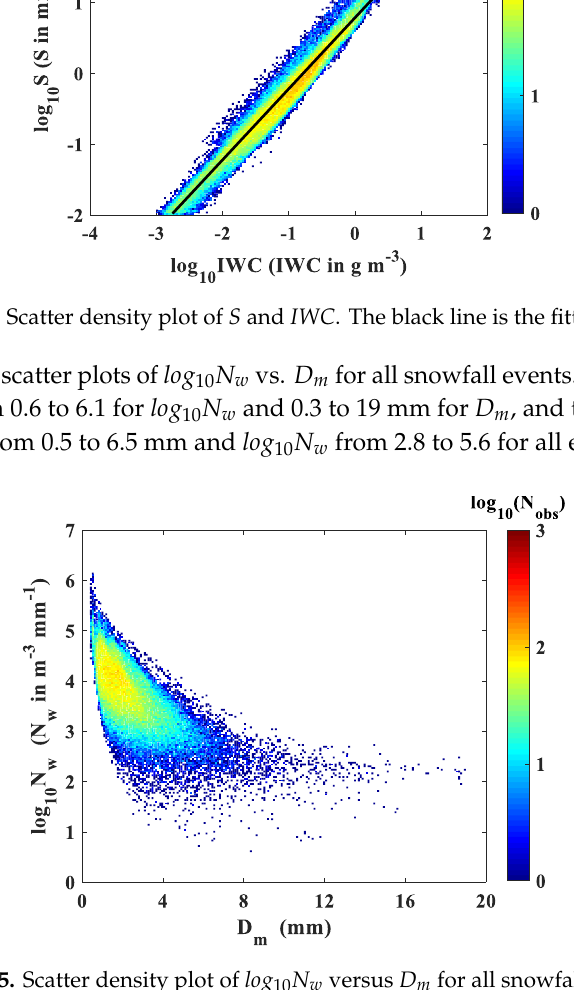
Figure 5. Scatter density plot of 𝑙𝑜𝑔 10 𝑁 𝑤 versus 𝐷 𝑚 for all snowfall events.